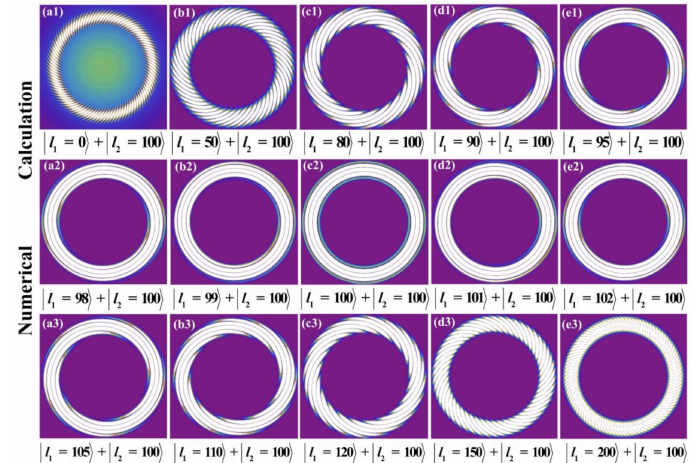
Figure 7. Numerical calculations of coaxial interference patterns between two vortex beams carrying TCs of large number. Row 1 shows the interference patterns between | l 1 = 0, 50, 80, 90, 95 (cid:105) and = 100 (cid:105) , row 2 shows the interference patterns between | l | l 2 and row 3 shows the interference patterns between | l 1 = 105, 110, 120, 150, 200 (cid:105) and | l 2 = 100 (cid:105)